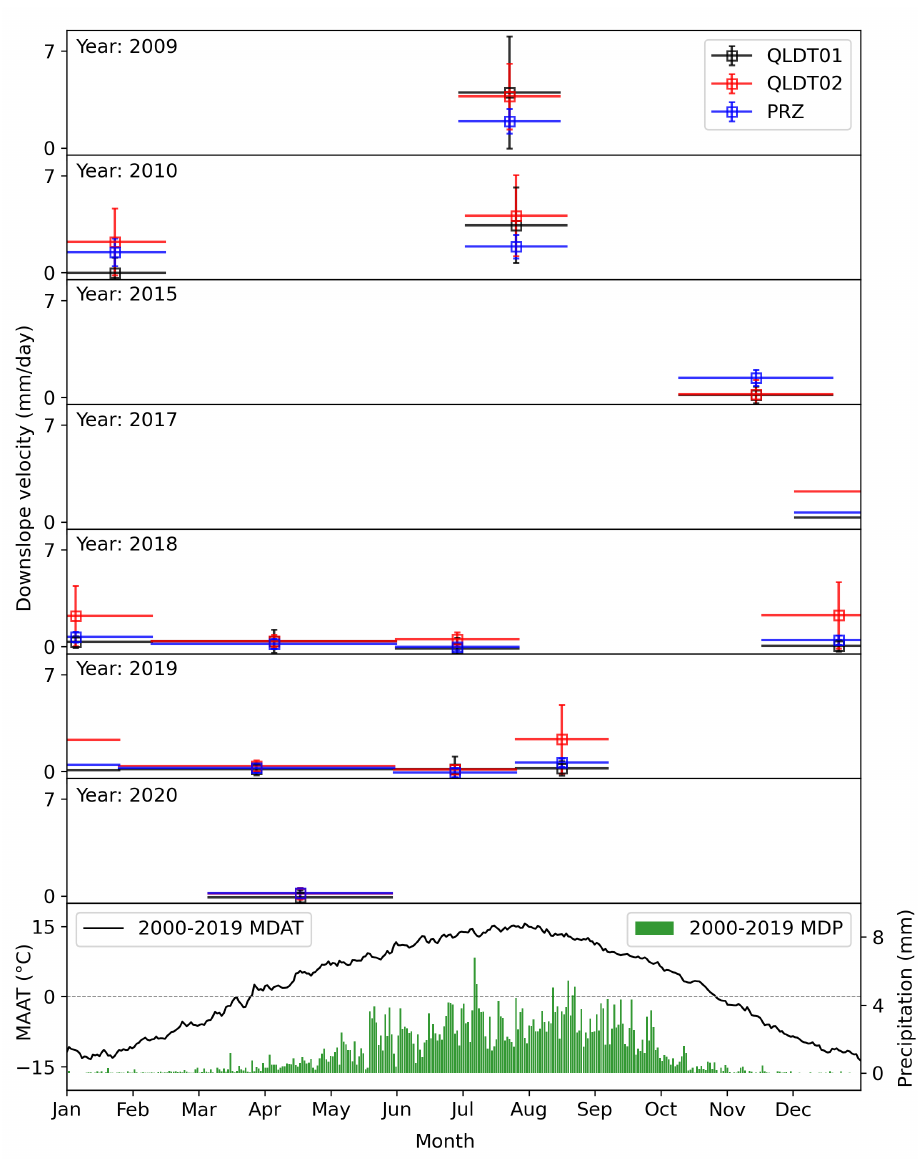
Figure 9. Temporal variations for 2000–2019 in mean daily air temperature (MDAT), mean daily precipitation (MDP), and average downslope velocities of QLDT01, QLDT02, and potential risk zone (PRZ) (Figure 5L). The squares present the average downslope velocities, whereas the corresponding lines show the start and end date of the SAR image pair. The error bars denote the standard deviation of downslope velocities within the red polygons. The bottom panel plots the MDAT and